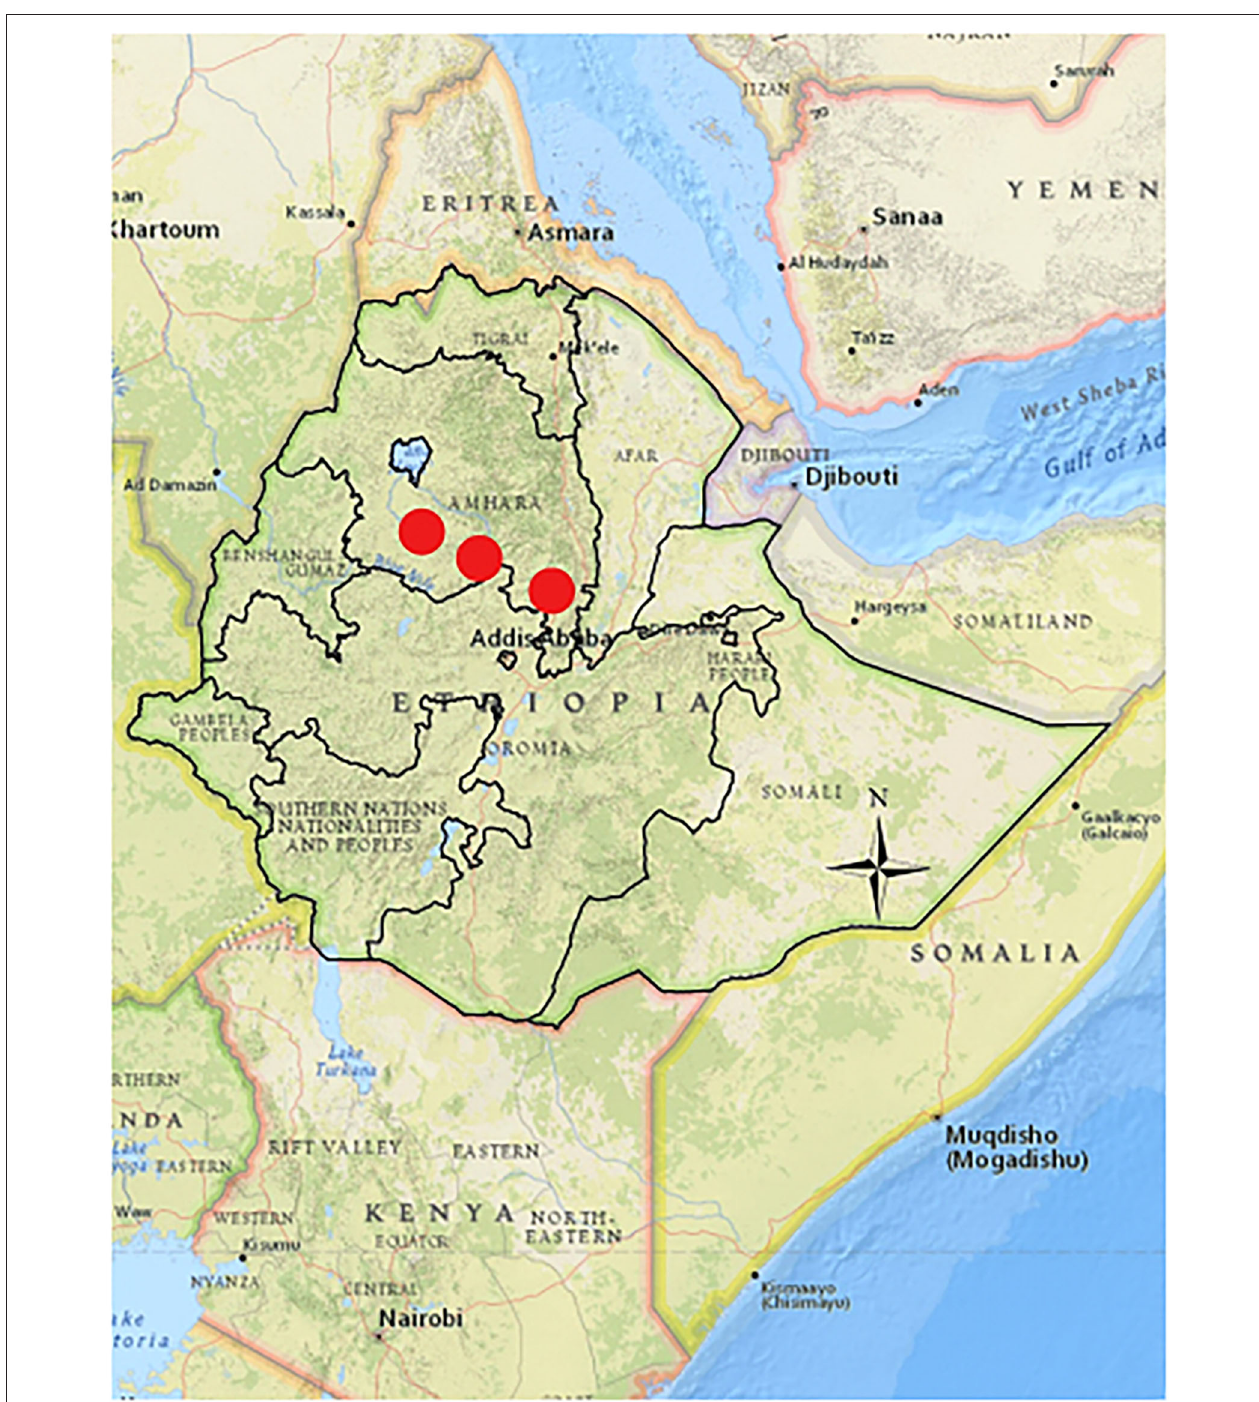
FIGURE 1 | Map of the study area in